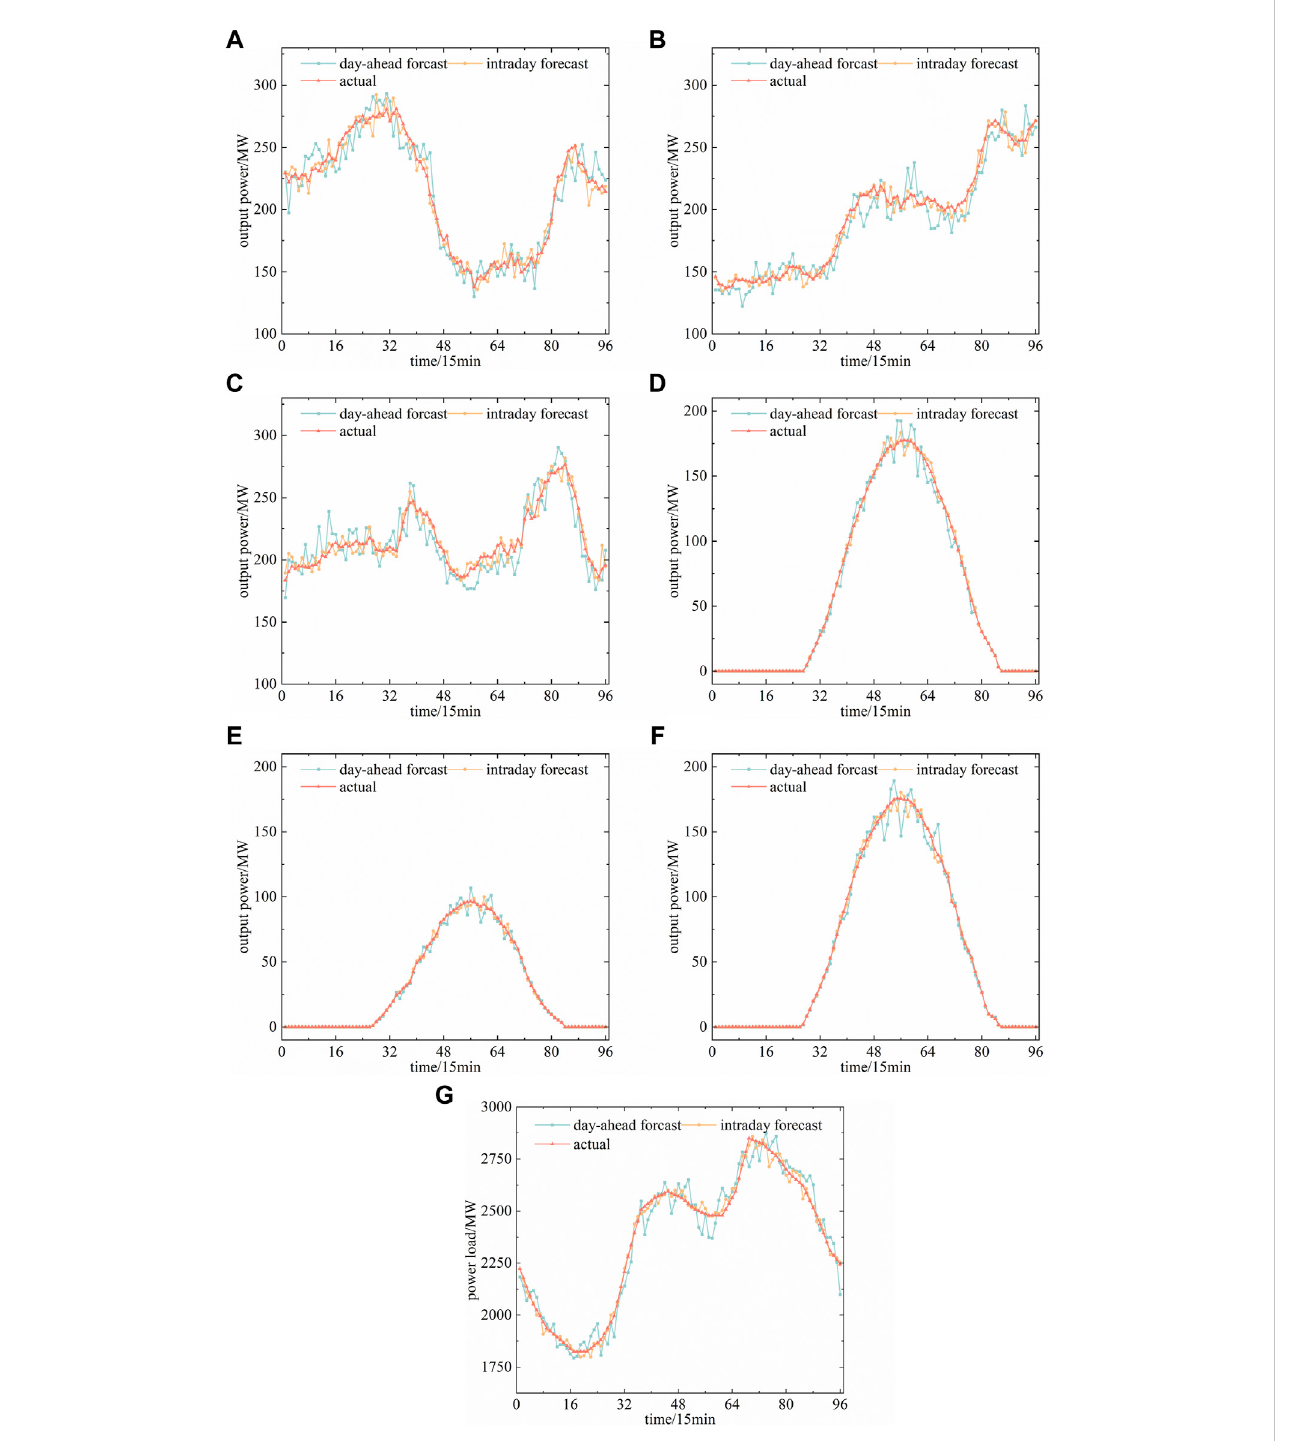
FIGURE 7 Forecast curves of the quantity in a system that needs to be forecasted: (A) WPP1, (B) WPP2, (C) WPP3, (D) PPP1, (E) PPP2, (F) PPP3, and (G) power load.